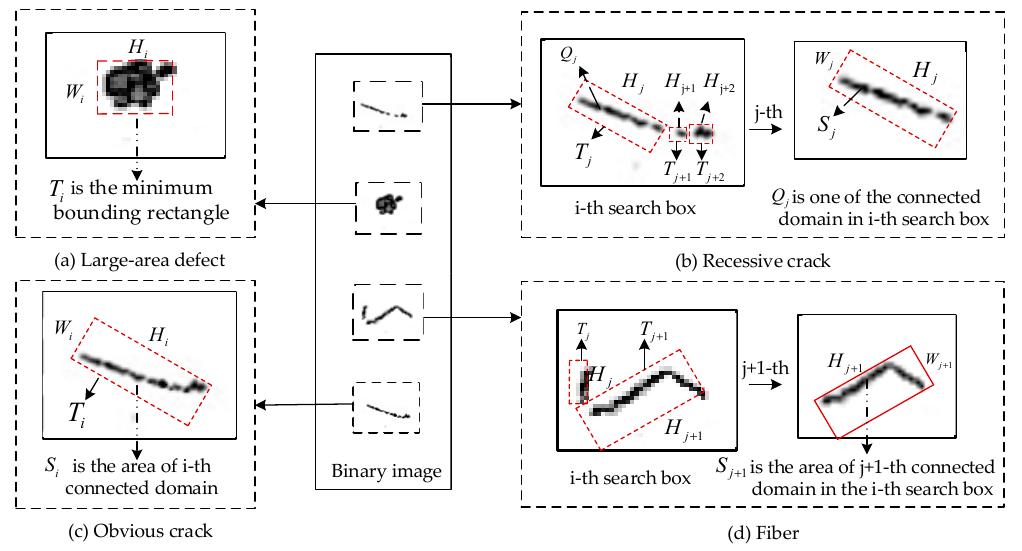
Figure 12. Illustratory diagram of connected domain filtering.